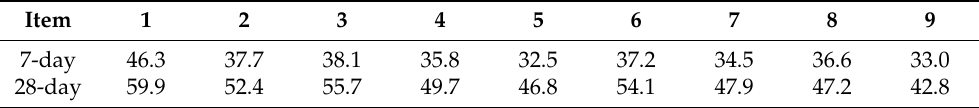
Table 4. The average compressive strength (MPa).